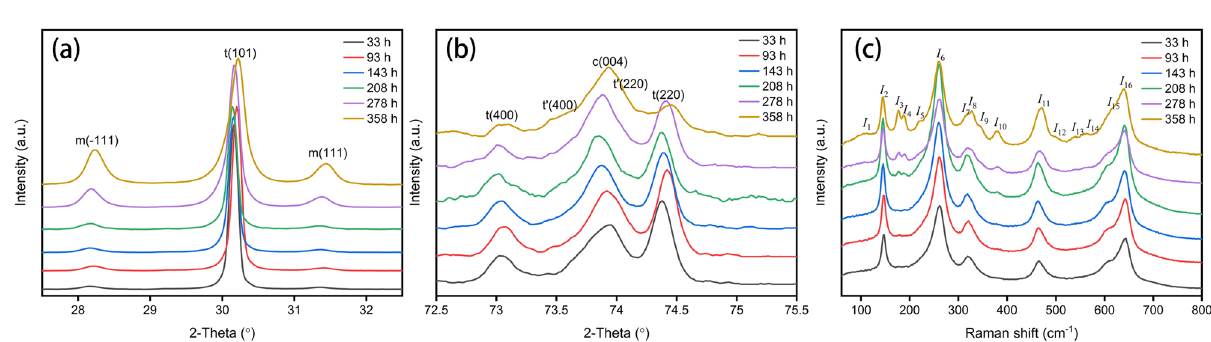
Figure 4. XRD patterns ( a ) 2θ = 27.5°–32.5°, ( b ) 2θ = 72.5°–75.5°, and ( c ) Raman spectra of 6.5YbYSZ ceramics after heat treatment for different